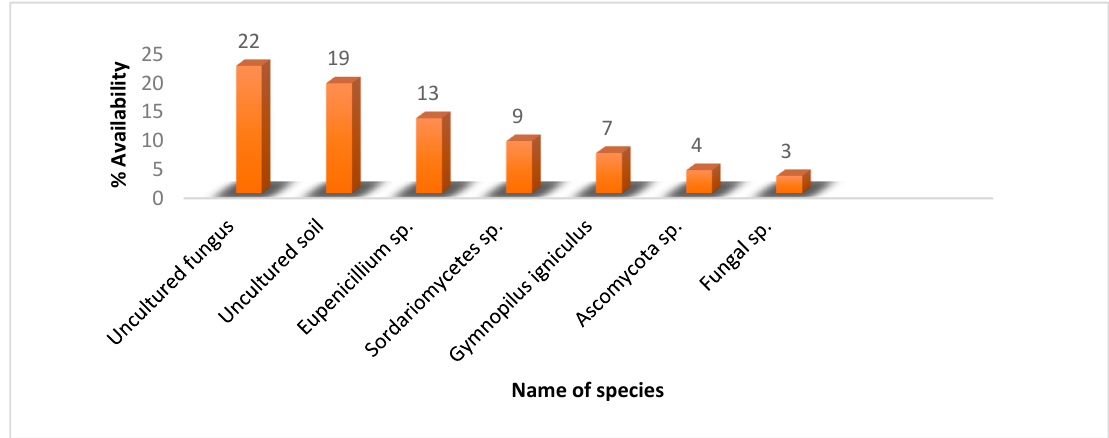
Figure 3. Representation of fungal species in Burkea soils.